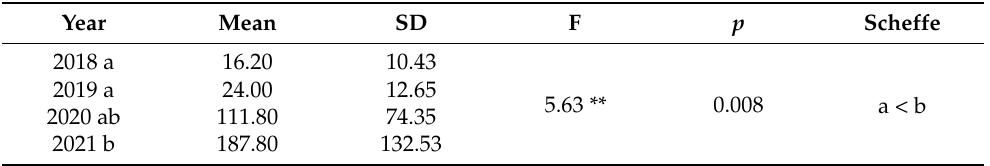
Table 8. Status of male victims of digital sex crimes by year.